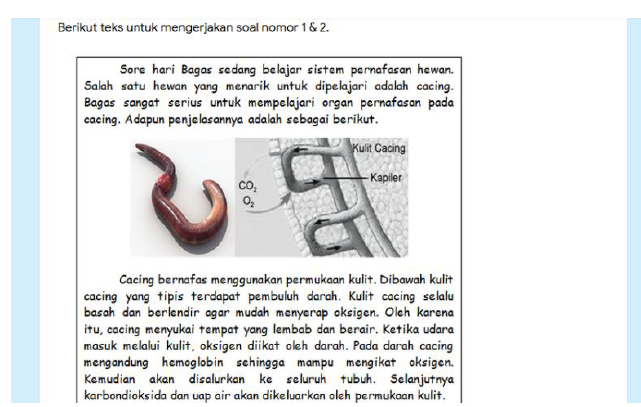
Figure 12. Judgement and critical thinking stimulus questions number 1 and 2, Package